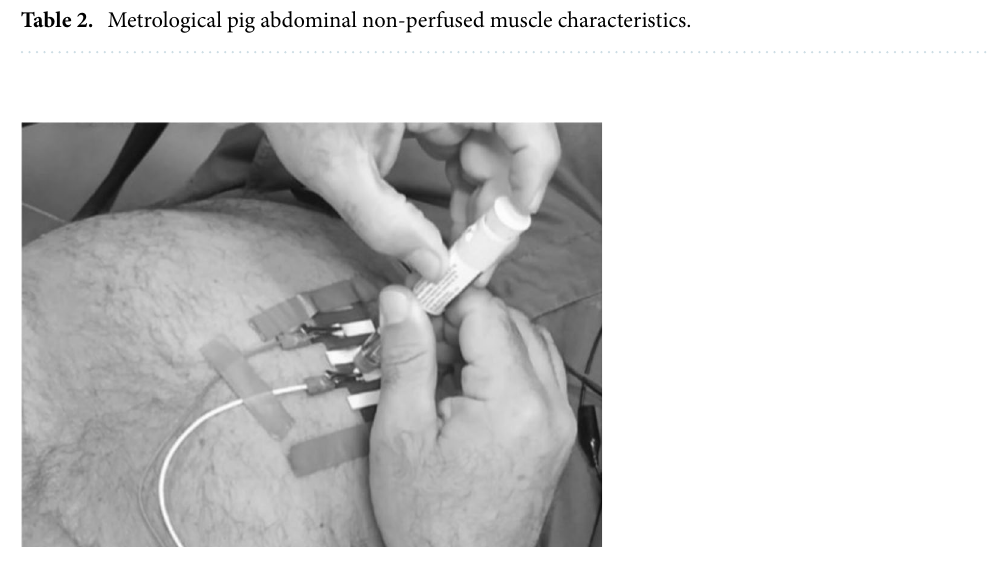
Figure 10. Insulin injection during in-vivo